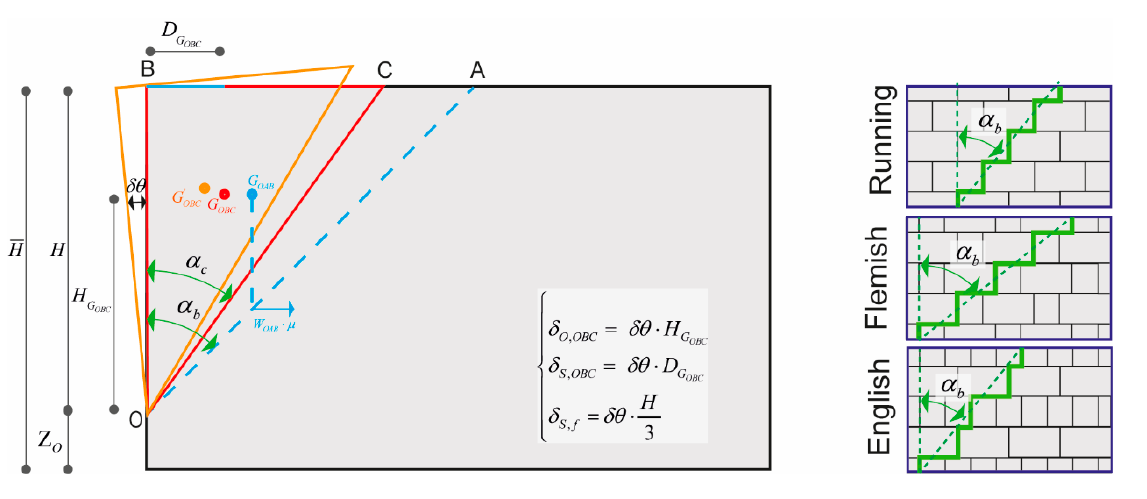
Figure 1. Kinematic description of the sliding-rocking mechanism for an in-plane shear wall and definition of α b for quasi-periodic bond patterns.